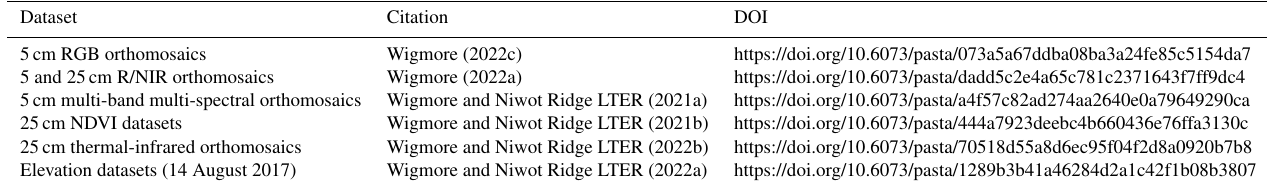
Figure 6. Close-up of TIR ( T s ) (top row) (25cm), RGB (middle row) (5cm), and NDVI (bottom row) (5cm) image pairs for 21 June 2017. (a) Snowmelt pathways through wet meadow; (b) snowmelt feeding wet meadow; (c) snow accumulation in the forest zone; (d) surface ponds fed by sub-surface hydrologic pathways. Table 3. Data availability, citations and DOIs. Dataset